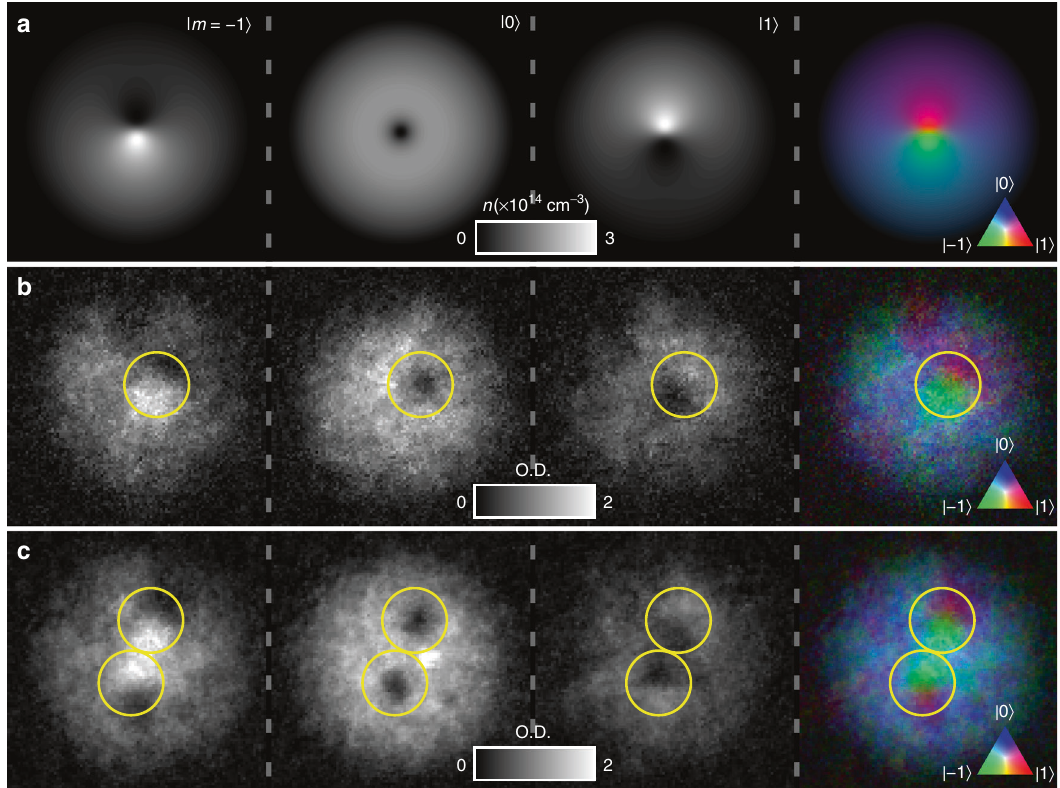
Fig. 7 Signature of SO(3) character. a Spinor component densities after applying a π /2 spin-tip pulse to the analytically constructed singly quantised vortex, Eq. (4), corresponding to a change of spinor basis. The vortex core is at the density minimum of the |0 〉 component. b , c Experimental absorption images of the atomic density, expressed in terms of dimensionless optical depth (O.D.), in each spinor component after applying a π /2 spin rotation for condensates containing one and two vortices, respectively. The vortex cores are identi fi ed by the density minima in the m = 0 component, and yellow circles are drawn around the corresponding locations in each spinor component and in the colour composite image. The false-colour composite images show alternating regions of m = ±1 components in the vicinity of the vortex core. The fi eld of view of each image in b , c is 219 μ m × 219 μ m. Source data are provided as